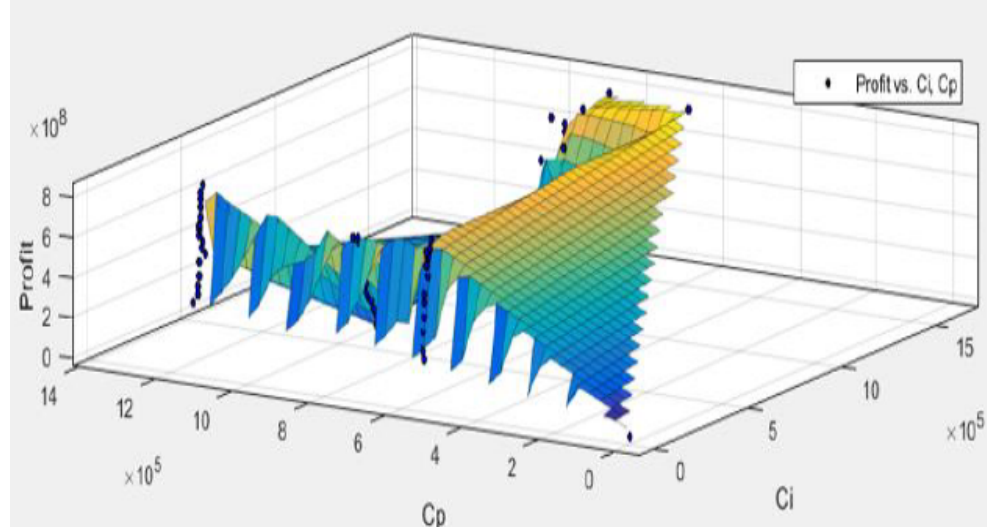
Figure 8. The curve of correlation between idea cost and production cost in advance SMEs.